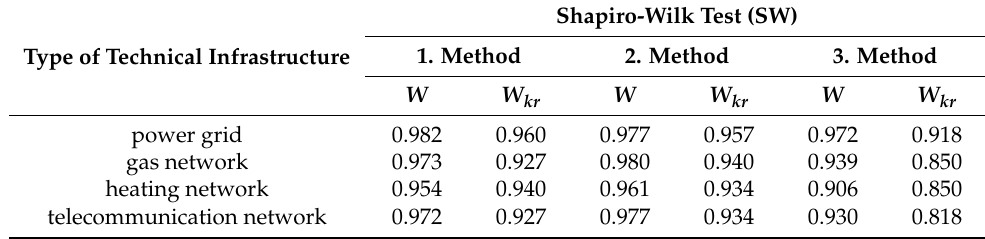
Table 4. Table showing the results of the SW.